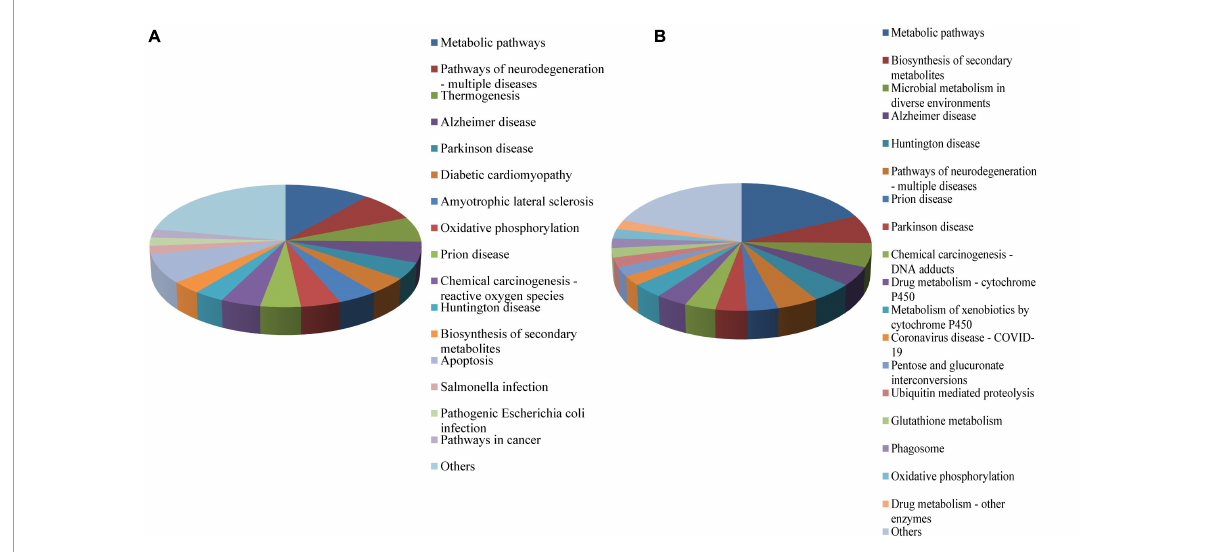
FIGURE2 KEGG functional classification of the DEPS in the midgut of Ae. albopictus identified by iTRAQ analysis. (A) KEGG functional classification of upregulated proteins; (B) KEGG functional classification of downregulated proteins. DEP, differential expressed protein; KEGG, Kyoto Encyclopedia of Genes and